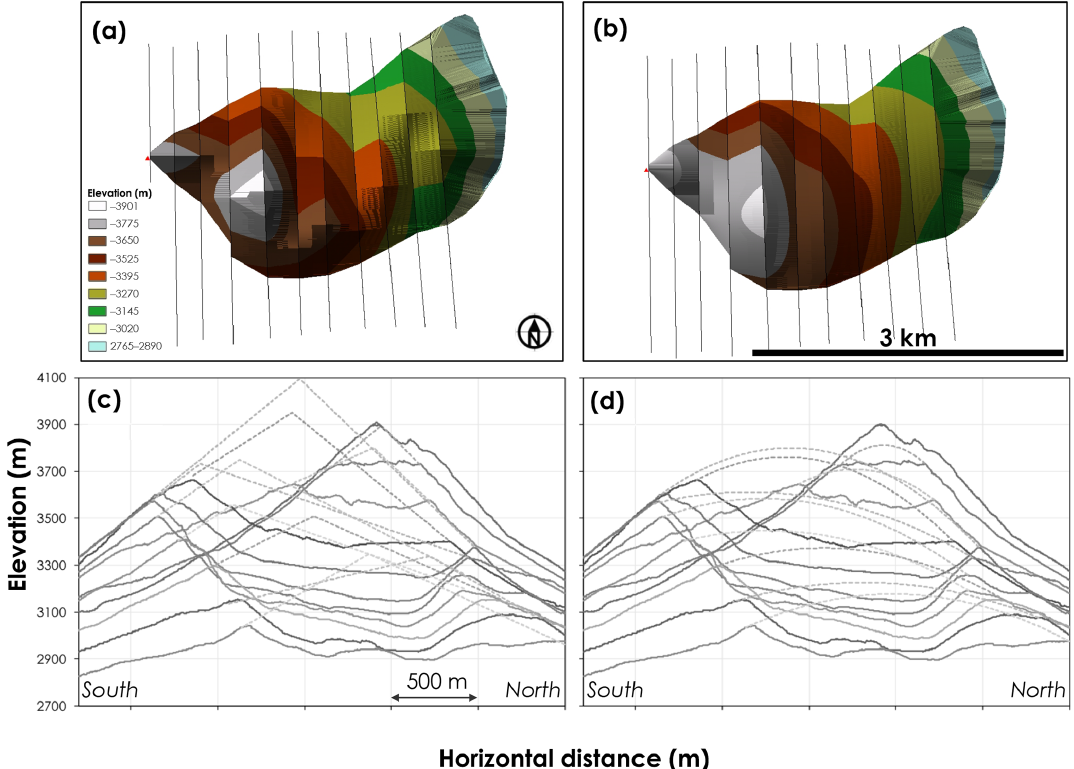
Figure 11. Reconstruction of the source area of the sector collapse. Scales are the same for a / b and c / d , respectively. (a) Plan view of the reconstructed surface by the linear method. The red triangle indicates the location of the current summit of Mt. Erciyes. (b) Plan view of the reconstructed surface by the Bézier method. (c) Transverse profiles of the original surface by the linear extrapolations. (d) Transverse profiles by Bézier curve fitting.